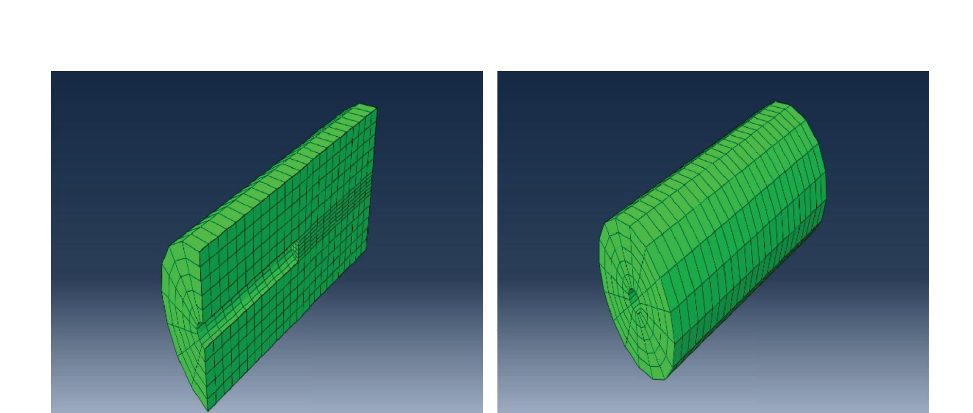
Figure 9: Concrete element meshing in ABAQUS software [1].